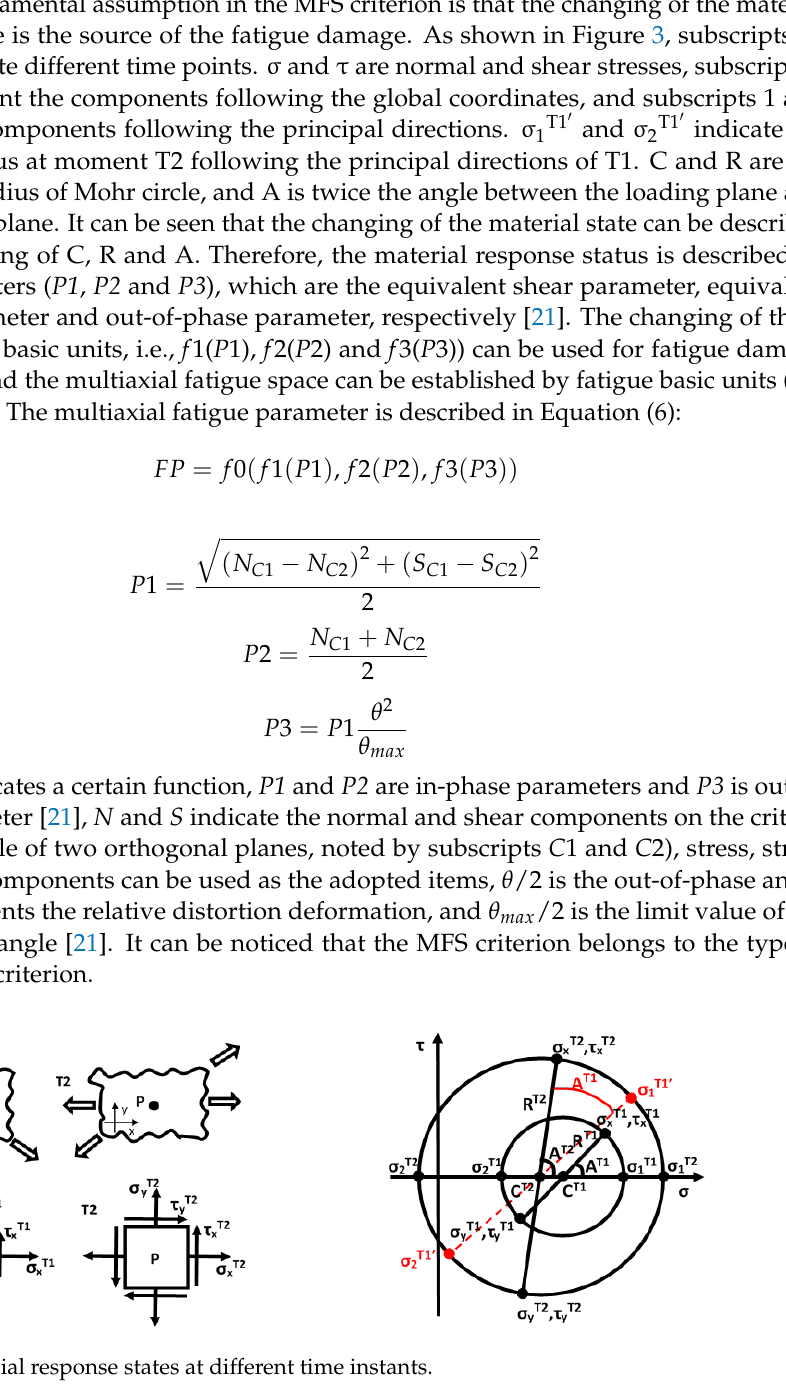
Figure 4. Multiaxial fatigue space. According to the MFS criterion, the amplitude of parameter variation (changing of P1 , P2 and P3 ) is the foundational component in multiaxial fatigue space, which is con- sistent with the definition of fatigue damage. The influence of the mean scales the vector OP in multiaxial fatigue space [21]. Therefore, the multiaxial fatigue parameter in Equa- tion (6) can be expressed by amplitude parameter ( 𝐹𝑃 𝑎 ) and mean parameter ( 𝐹𝑃 𝑚 ). See Equation (10):